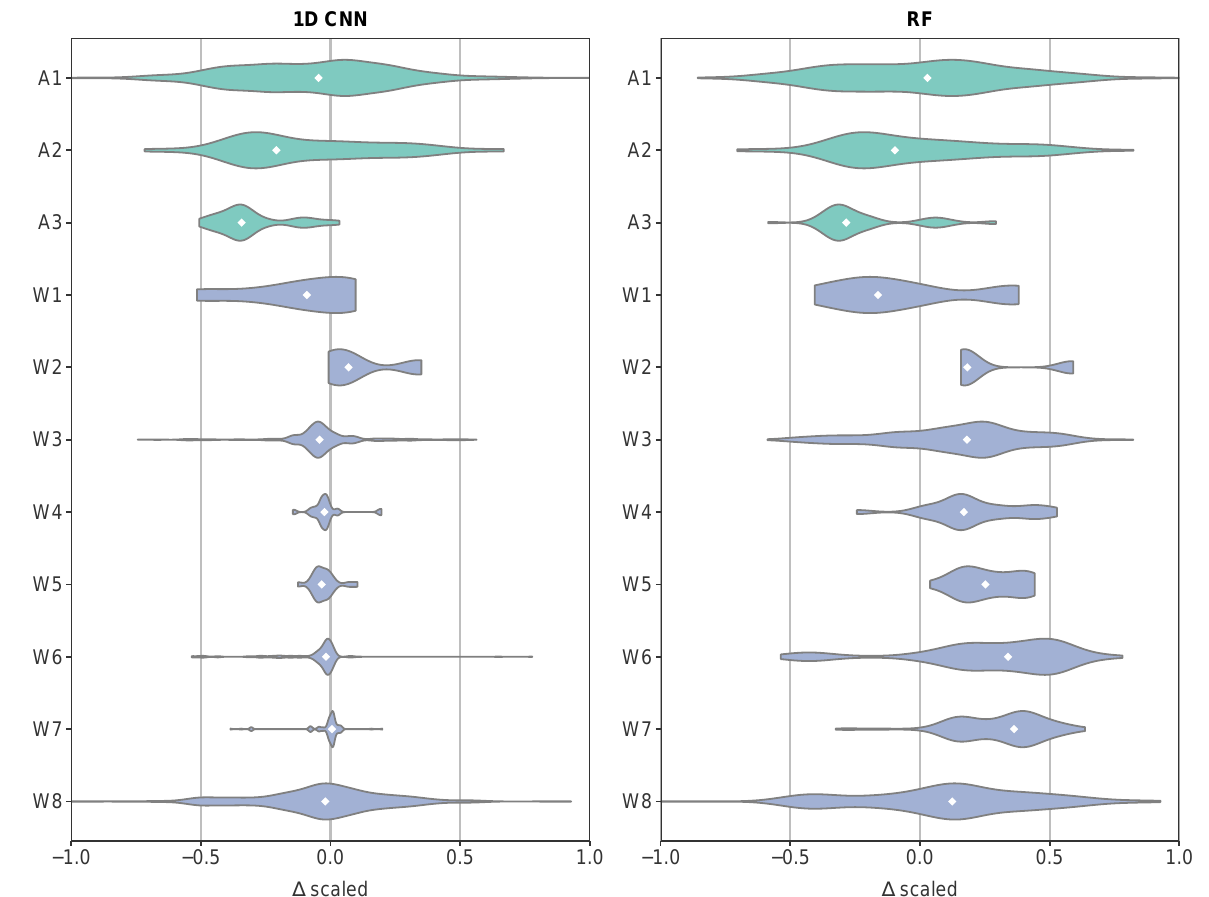
Figure 10. Visualization of the estimation results on the SR-EnMAP resolved data generated by the 1D CNN (left) and the RF model (right) as the min-max scaled deviation ∆ scaled between the estimated and measured chlorophyll a values. The violin plots reveal the median of the deviations between the scaled estimated and scaled measured chlorophyll a values (white dot) and the entire distribution of these